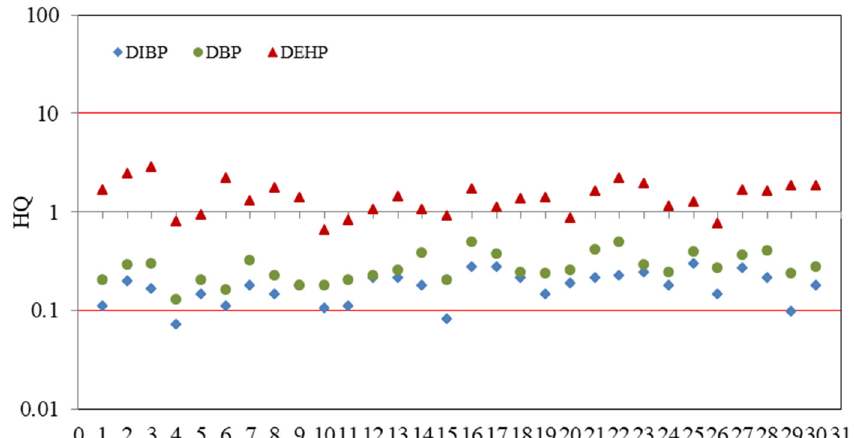
Figure 3. Ecological risk assessments of ∑ 3 PAEs in Baiyangdian Lake.